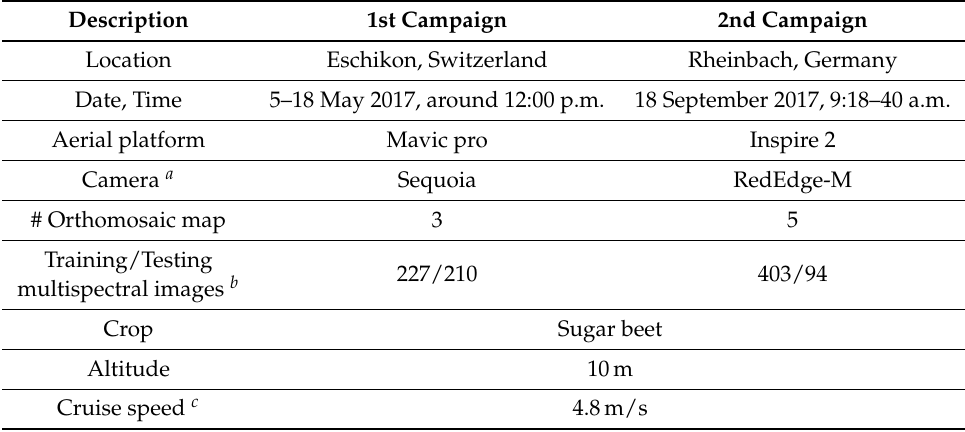
Table 2. Data collection campaigns summary.